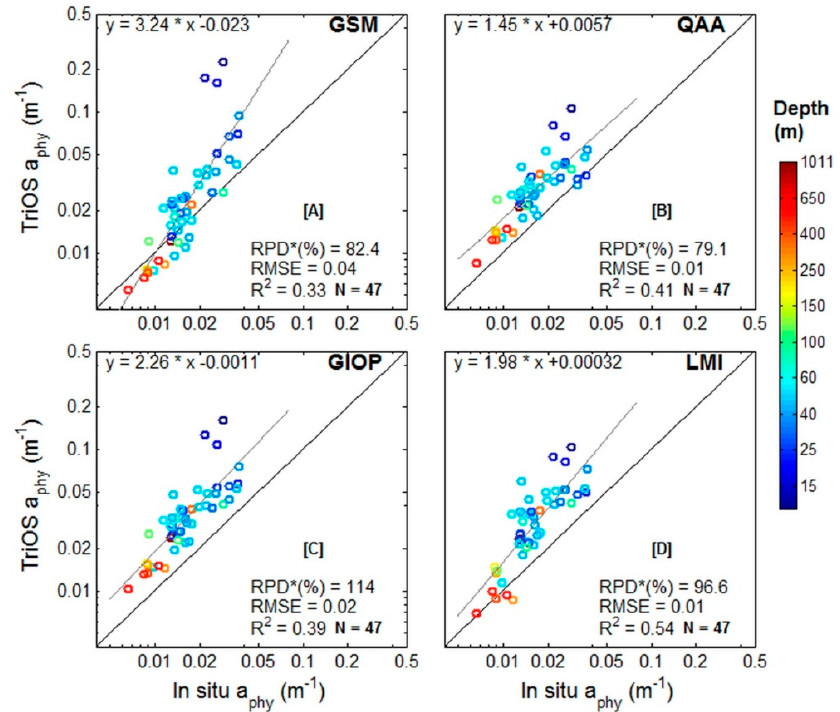
Figure 12. Comparisons between the in situ measured and modelled phytoplankton absorption ( a phy ) at 443 nm using Remote sensing reflectance from TriOS radiometer (R rs T) (TriOS a phy ) obtained with: Garver-Siegel-Maritorena (GSM01) ( A ), Quasi-Analytical Algorithm (QAA) ( B ), Generalized IOP (GIOP) ( C ) and Linear Matrix Inversion (LMI) ( D ) (Number of samples = 47). Axes in log scale.